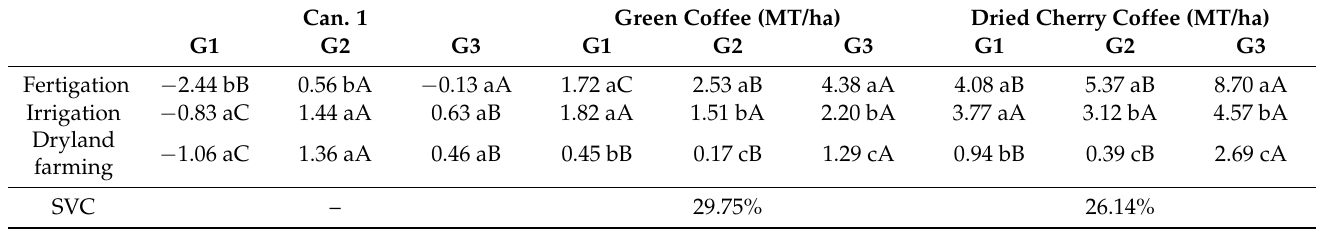
Table 3. Average values of production systems and coffee genotypes (G1—clone “25”; G2—clone